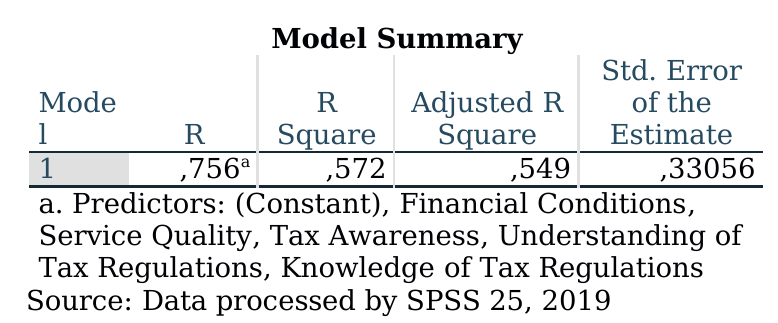
Table 3. Coefficient of Determination Test Result (R 2